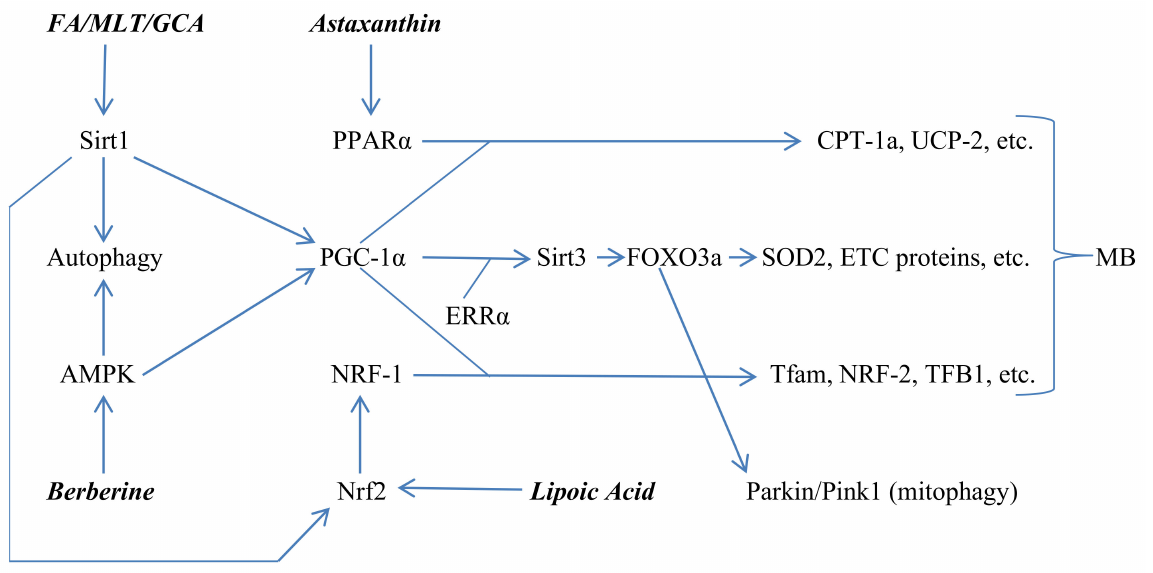
Figure 2. Roles for Sirt1, AMPK, Nrf2, and PPAR α in promotion of mitochondrial biogenesis (MB) and autophagy/mitophagy. FA = ferulic acid; MLT = melatonin; GCA =